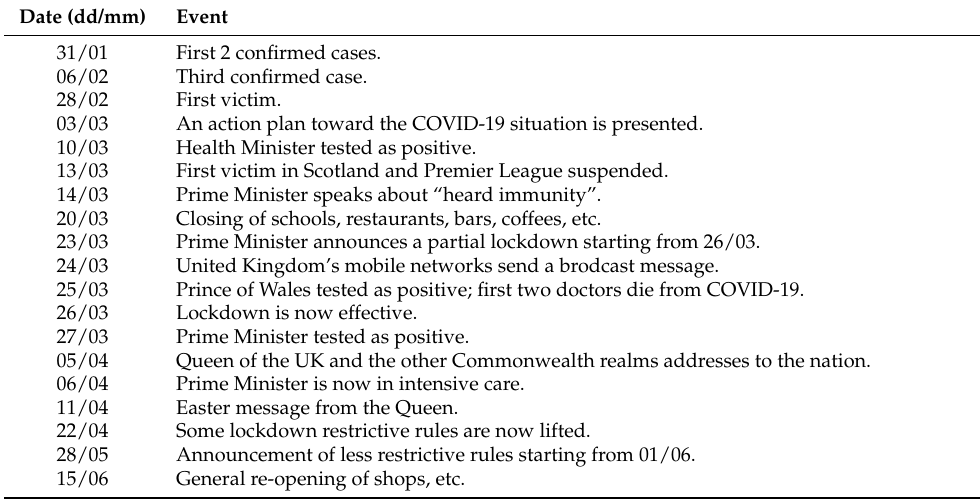
Table 8. Events and policies timeline related to the COVID-19 epidemic situation in the UK.